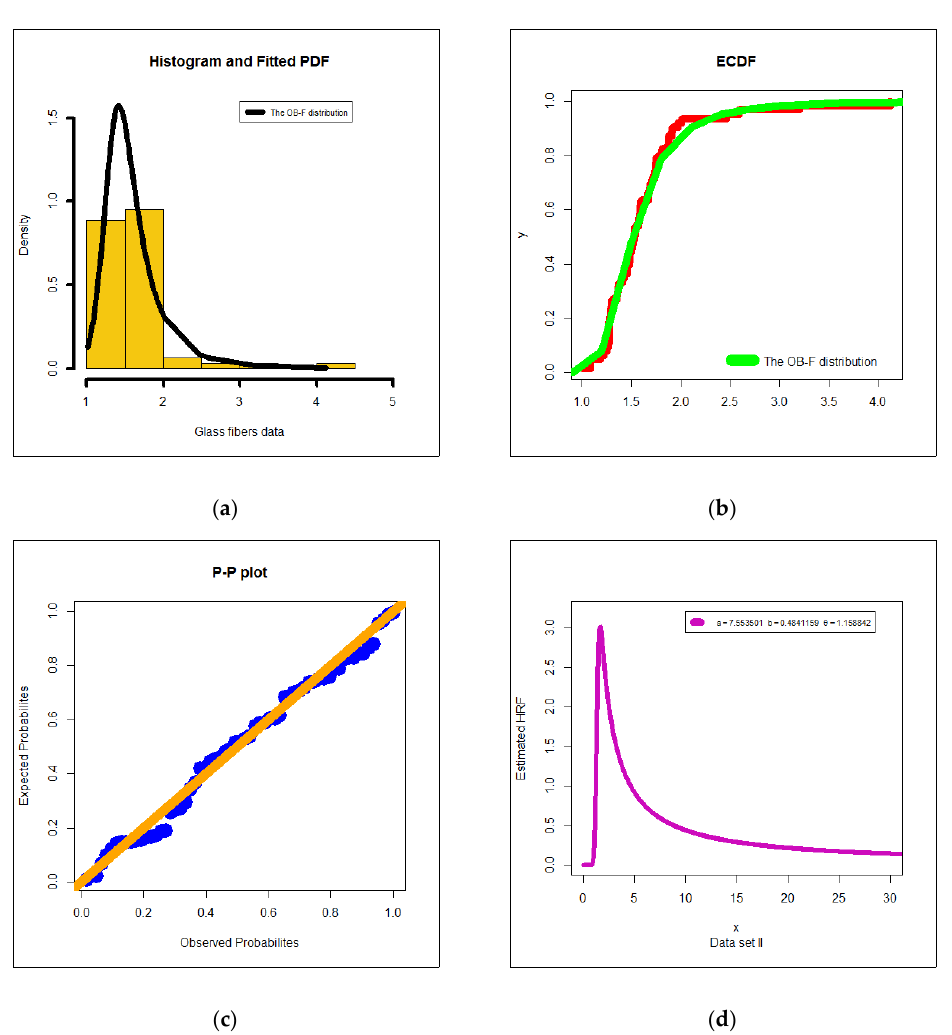
Figure 5. ( a ) Estimated density; ( b ) estimated CDF; ( c ) P-P plot; ( d ) estimated HRF for data set II